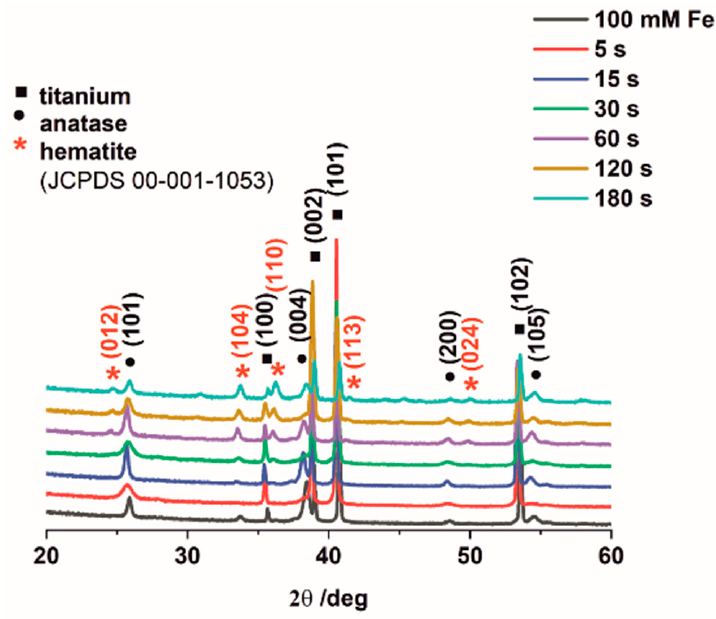
Figure 3. XRD patterns of all studied Fe 2 O 3 –TiO 2 materials.